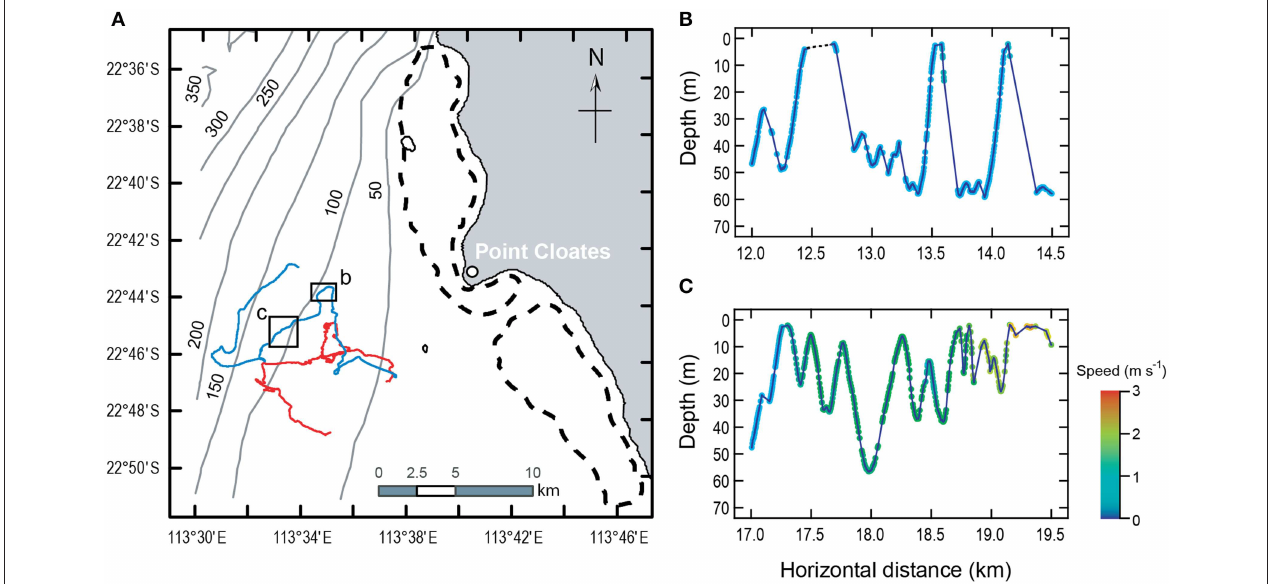
FIGURE 1 | Movements of two whale sharks for 16–17h at Ningaloo Reef, Western Australia. (A) Positions were dead-reckoned at 1s intervals using speed, depth, and magnetometer information and corrected using known locations at deployment and recovery. Color of the swimming path distinguishes the whale sharks (red: 7-m long; blue: 4-m long). Arrows show direction of movement. Boxes in (A) delineate region of detail shown in (B,C) . Broken lines identify Ningaloo Reef. Gray lines are bathymetric contours (numbers indicate depth in m). Both sharks swam away from the reef during the morning and afternoon and toward the reef in the evening, each covering roughly 40 km (including both vertical and horizontal movement). They spent 79.4 and 58.6% (larger and smaller shark, respectively) of the time performing “dives” (descent from near the sea surface toward the bottom followed by immediate ascent) or swimming horizontally, usually near the sea floor. The remainder of the time was within 5m of the sea surface. Dives were characterized by slow, constant speeds, and gliding descents (B) although some isolated instances of gliding did occur on ascent. High speeds and powered descents (C) were rare. Each point in (B,C) represents depth and horizontal distance from start of deployment for a propulsive stroke. Symbol color indicates swimming speed. Gaps between points show periods of gliding.